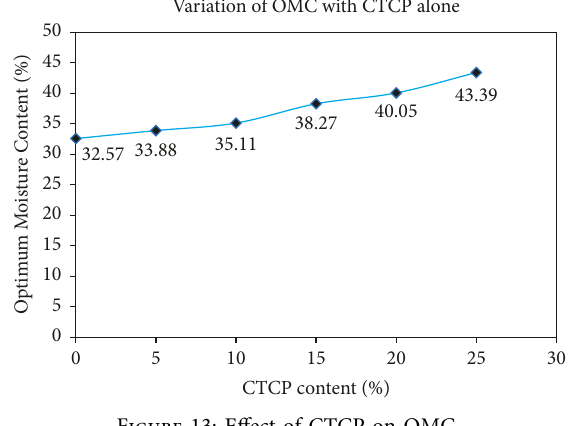
Figure 13: Effect of CTCP on OMC.